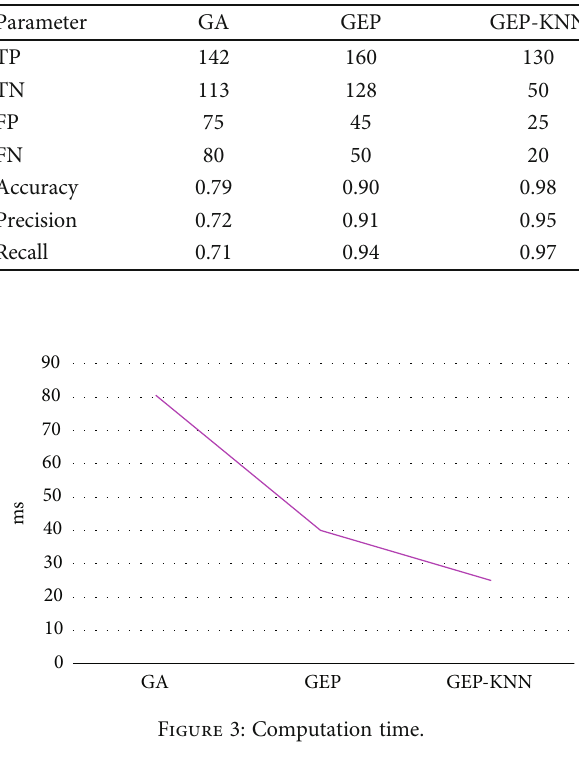
Table 4: Metric measure report.